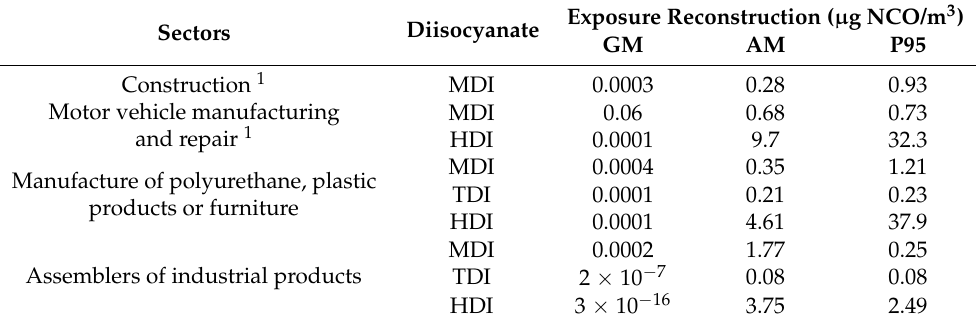
Table 5. Exposure reconstruction from biomonitoring data based on diisocyanate exposure in specific sectors in Finland. The exposure reconstruction was performed using a PBPK model for MDI and TDI and a regression modelling equation for HDI. All measured median levels were <LOQ; therefore, no reconstructed P50 levels are presented. The corresponding reconstructed urinary levels are presented in the Supplementary Materials, Table S3.